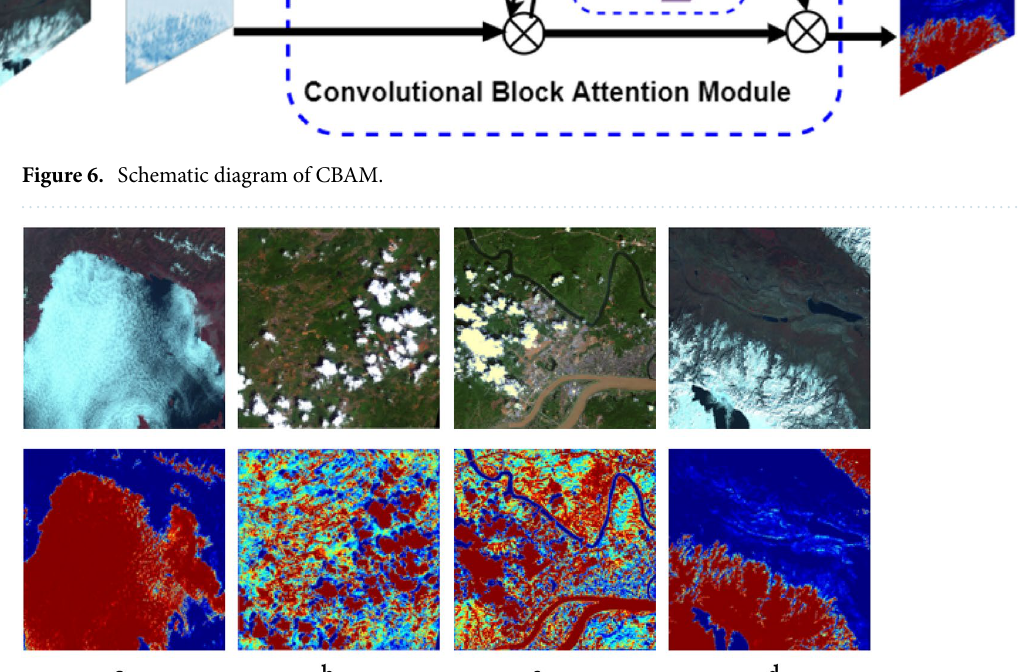
Figure 7. Schematic diagram of CBAM output results. Wherein, the original remote sensing image of the previous act and the CBAM output result corresponding to the next act. The areas in dark red indicate the areas where the network is